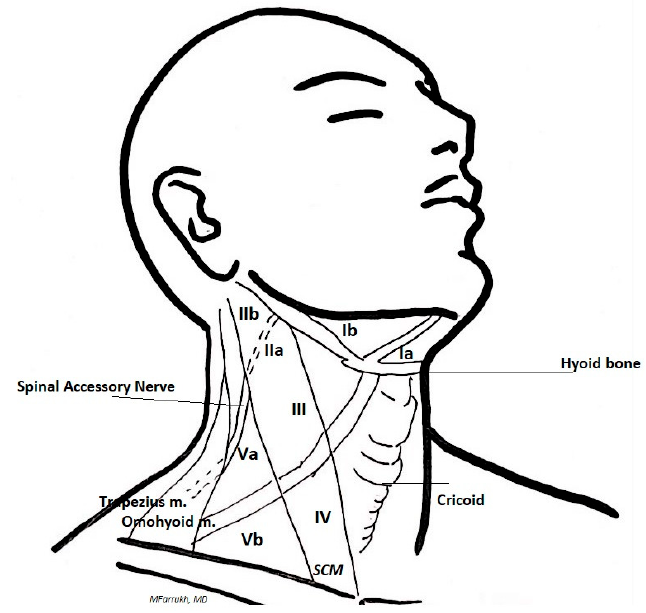
Figure 1. Lymph node levels of the neck and landmarks for lymphadenectomy.